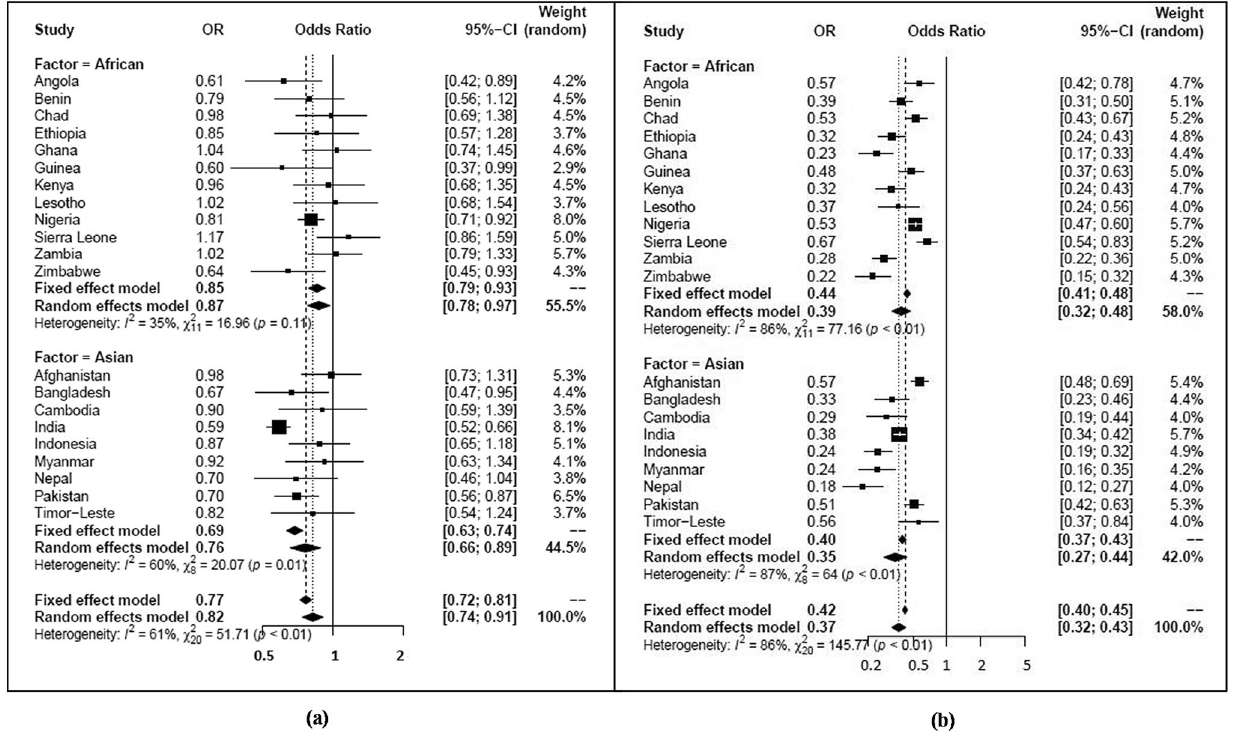
Fig. 3 Forest plot of subgroup analysis for a mother’s education and b ANC